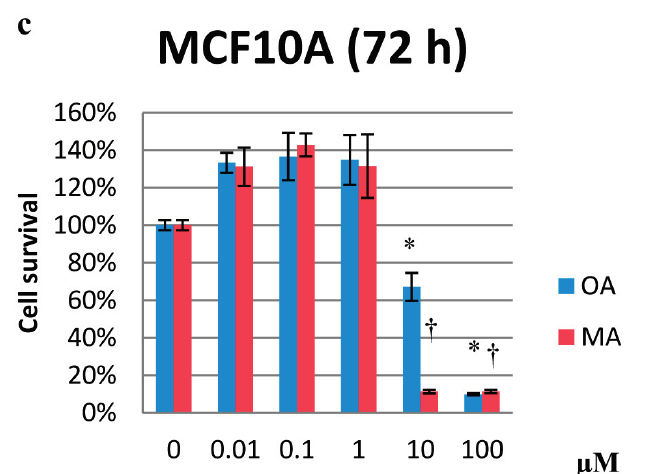
Figure 2. Percentage of cell proliferation in MCF10A cells after treatment with 0.01 µM to 100 µM OA or MA at 24 ( a ); 48 ( b ) and 72 h ( c ). Values represent the mean ± SEM of three independent experiments. Statistically significant differences are represented by (*) for OA and (†) for MA at p < 0.05 with respect to the untreated